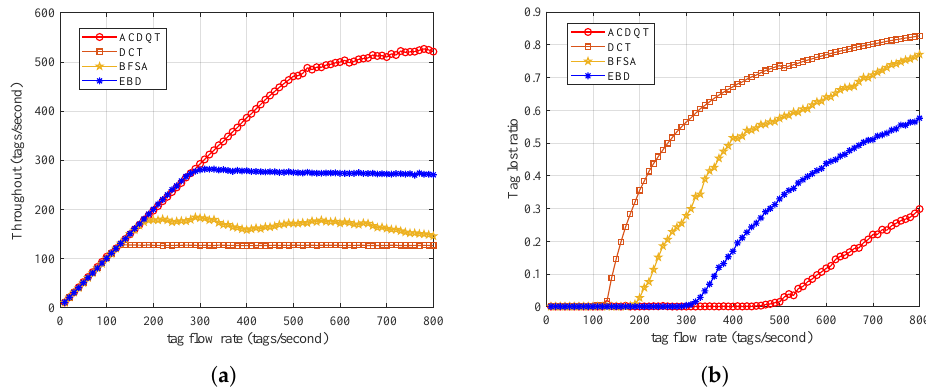
Figure 11. Identification performance for fast-moving tags: ( a ) throughput; ( b ) tag lost ratio. As can be observed from Figure 11a, the proposed ACDQT algorithm achieves much higher throughput than comparable algorithms, and the highest throughput is about 510 tags/s. Compared with EBD, BFSA and DCT, the throughput is improved by 20%, 85% and 140%, respectively. When tag flow rate is greater than 510, the throughput of ACDQT basically tends to be stable. However, when tag flow rate of BFSA is greater than 160, the fluctuation of throughput is relatively large, and it changes around 150. Since DCT directly repeats the identification process for fast-moving tags, it is limited by the performance of the tree splitting process. When new tags enter the reader’s reading range, they join the identification process immediately, which may collide with other participating tags. This greatly lowers the throughput in mobile systems. In EBD, newly arrived tags will participate in the identification process in the next round which relieves the collision situation. It also uses a new bit tracking strategy to accelerate the identification process in each round. Thus, its throughput is higher than DCT and BFSA but lower than ACDQT. In Figure 11b, the tag lost ratio of ACDQT is 0 when tag flow moves slower than 470 tags/s, while in DCT, BFSA and EBD, the values are 120, 170 and 290, respectively. After these points, the tag lost ratio increases with the tag flow rate. This is because with the tag flow rate increasing, the reader does not have enough time to identify all tags in the current round before they move out of reading range. In this situation, some tags may leave unrecognized after they move out of the reader’s reading range, resulting in a lost tag. With larger tag flow rate, the lost tag situation becomes worse. Nevertheless, the proposed ACDQT has much higher throughput and a lower tag lost ratio than comparable algorithms, which is more suitable to be implemented in fast-moving RFID systems. Finally, Table 7 lists the overall results of the comparable algorithms in single round and fast-moving situations. Note that the bold values refer to the best performance in each group, and the results are in accordance with these in Figures